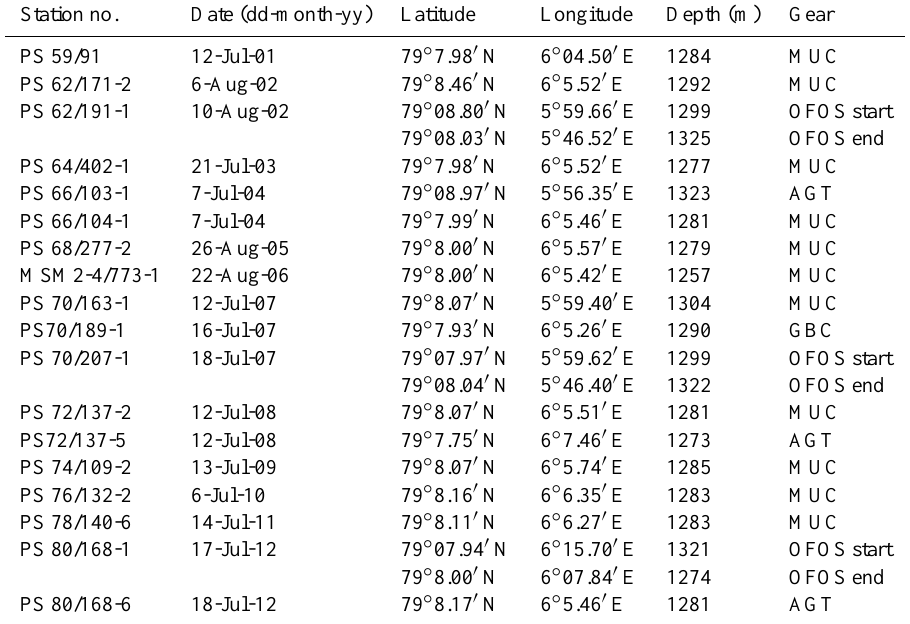
Table 1. Summary of gear deployments conducted at HG I. (MUC) multiple corer, (OFOS) Ocean Floor Observation System, (AGT) Agassiz trawl, (GBC) giant box core. Station